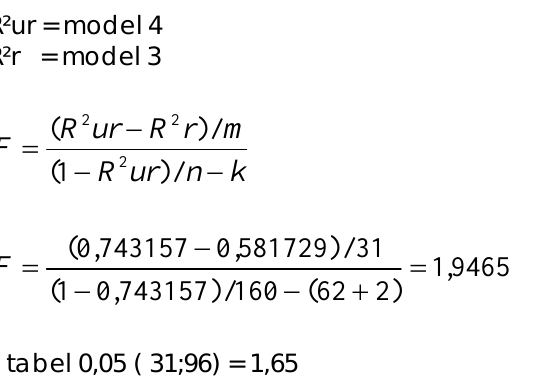
Restricted F test ( model 3 dan model 4 )